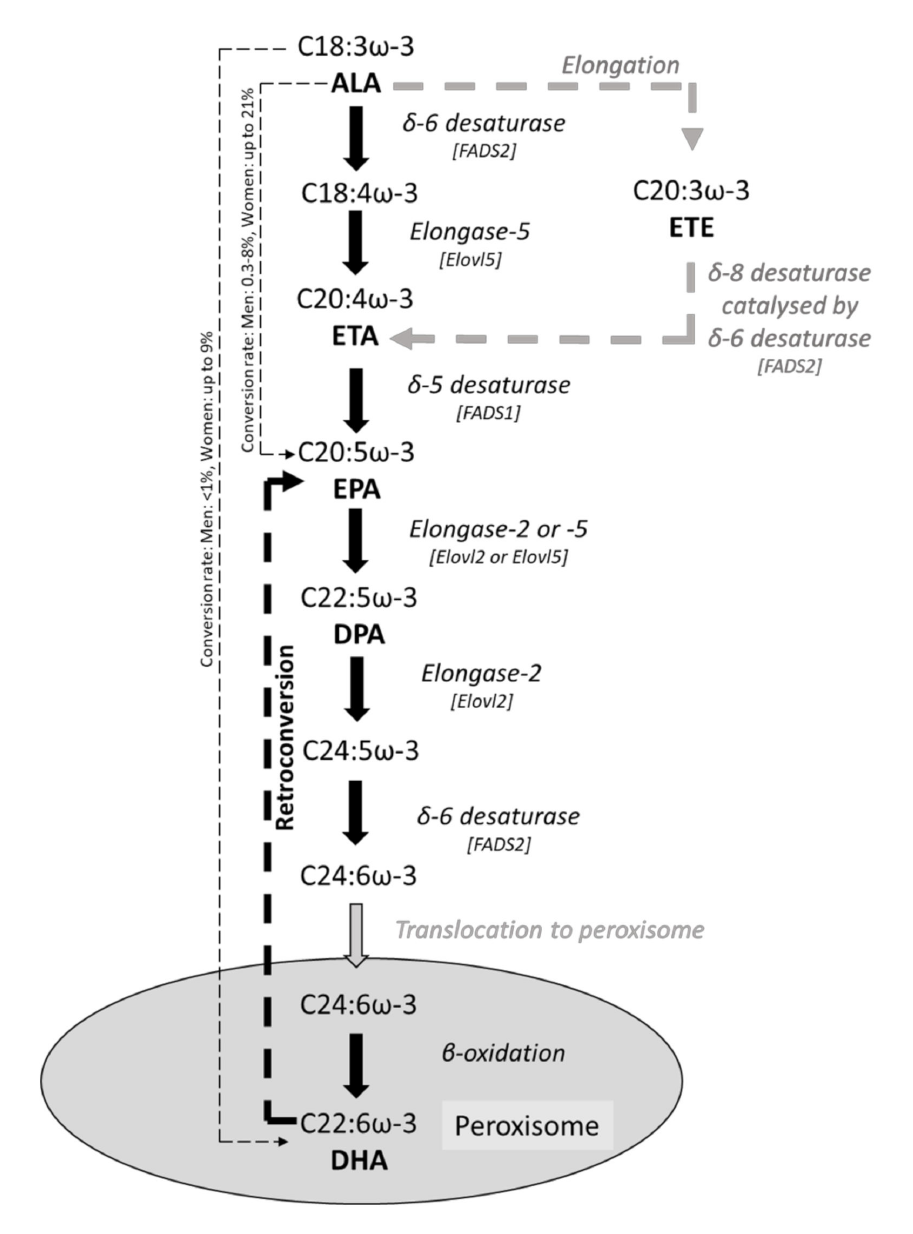
Figure 1. Metabolic conversion pathway from the essential ω -3 PUFA, ALA, to longer-chain ω -3 PUFAs, EPA, DPA and DHA. Conversion data are from